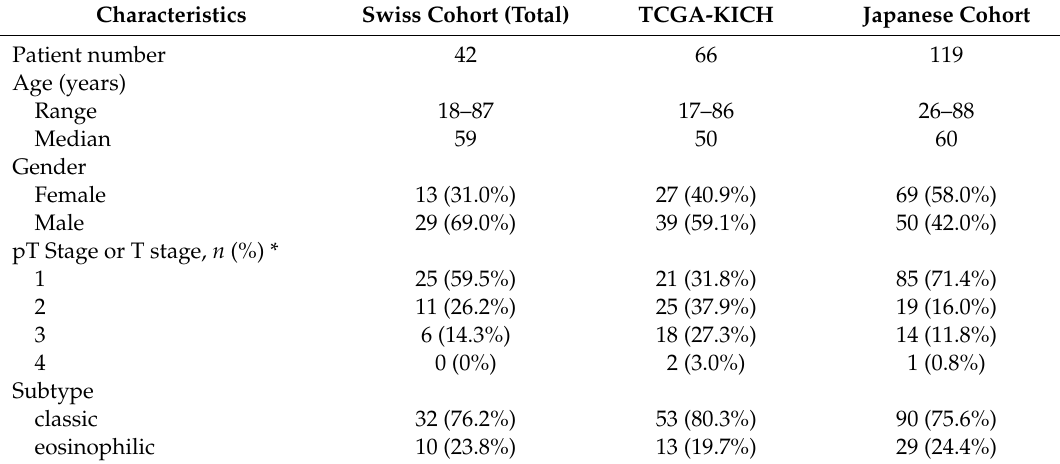
Table 1. Demographic and clinical characteristics.